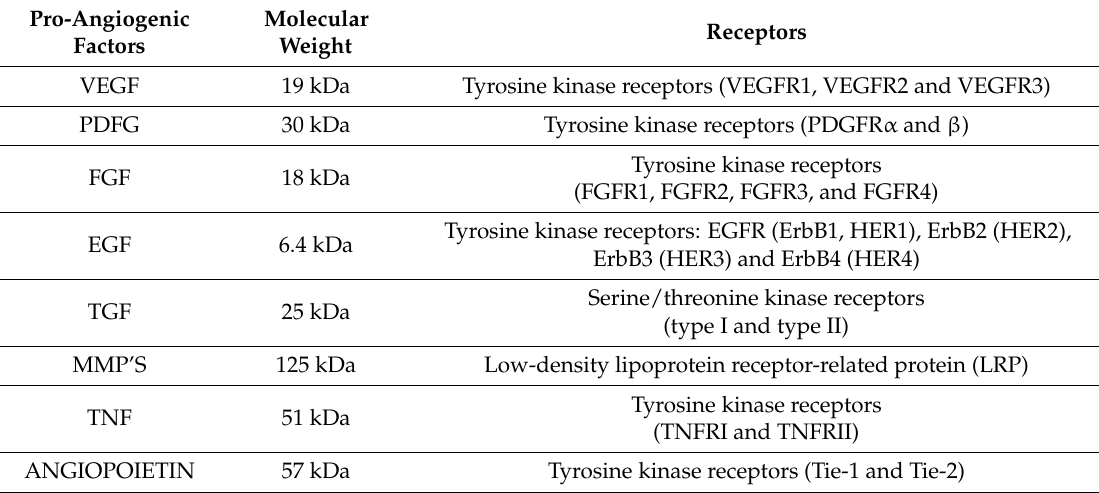
Table 1. Pro-angiogenic factors, molecular weight and receptors.